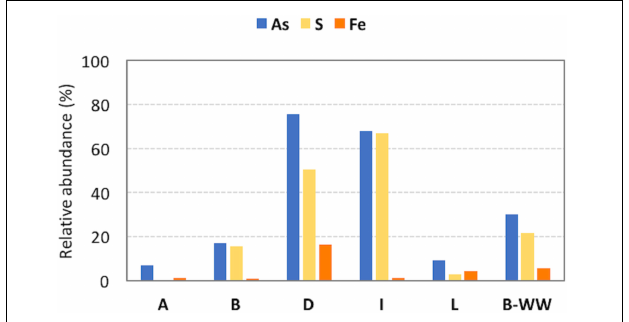
FIGURE 2 | Relative abundances of microorganisms in the 16S rRNA amplicon sequencing library potentially involved in arsenic (As), sulfur (S) and iron (Fe) cycles in the different samples. The vast majority of S cycle-related species belong to Sulfuricurvum spp. in groundwaters B, D and I and to Thiothrix spp. in biofilter unit B-WW.